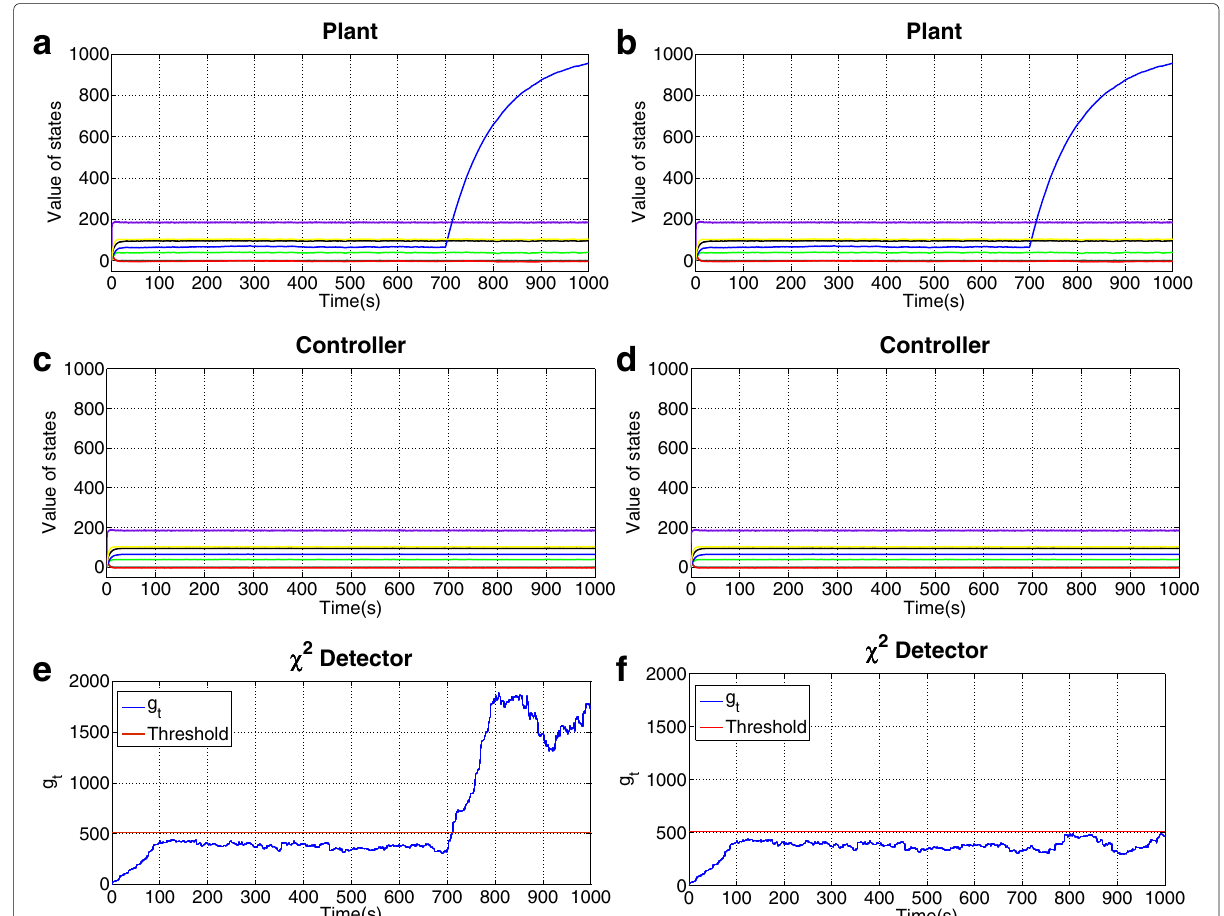
Fig. 3 Numeric simulation results. Attacks start at t = 700 s. a , c The dynamics of the state vector in the plant and in the controller under the cyber adversary attack. b , d The dynamics of the state vector in the plant and in the controller under the non-parametric cyber-physical adversary attack. e , f χ 2 detector results under the two aforementioned attack scenarios. a Plant states, cyber adversary attack. b Plant states, non-parametric cyber-physical adversary attack. c Estimated states in the controller, cyber adversary. d Estimated states in the controller, non-parametric cyber-physical adversary. e Detector results, cyber adversary. f Detector results, non-parametric cyber-physical